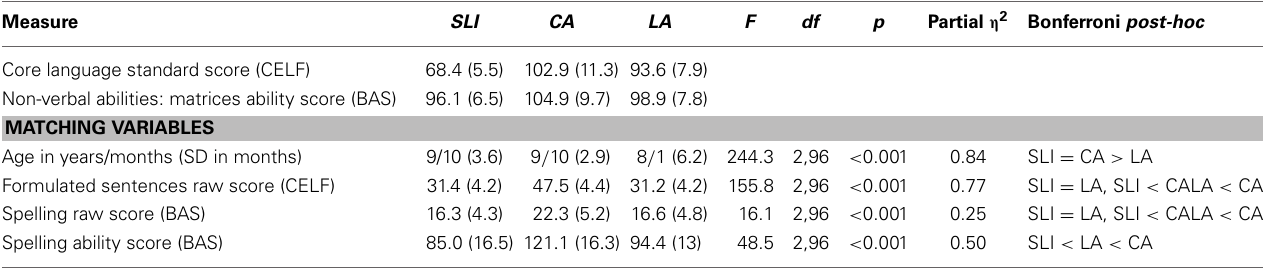
Table 1 | Means, (standard deviations), f score, df, p -value, effect size and Bonferroni post-hoc results (where applicable) for screening measures per group: SLI, CA, LA.